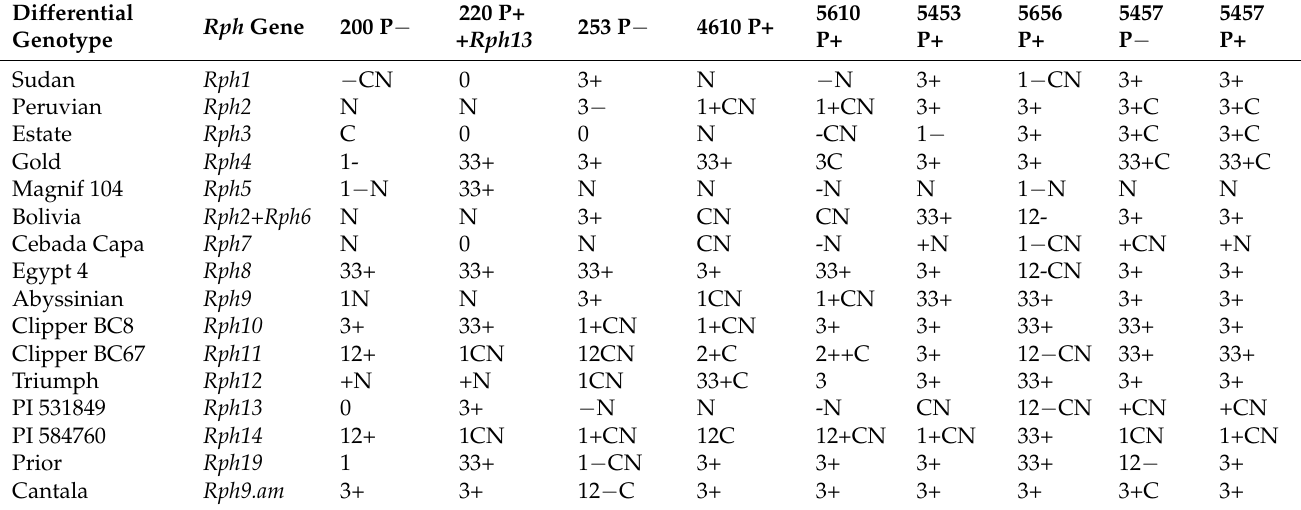
Table 2. Infection-type 1 responses of differential genotypes with nine pathotypes of Puccinia hordei , based on which Rph genes were postulated.